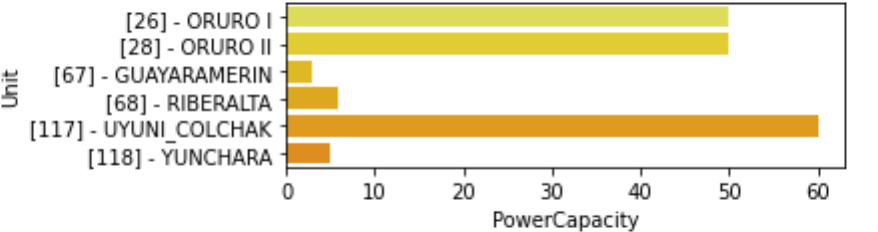
Figure 12. SOLAR ENERGY implemented and planned in the period 2020–2025